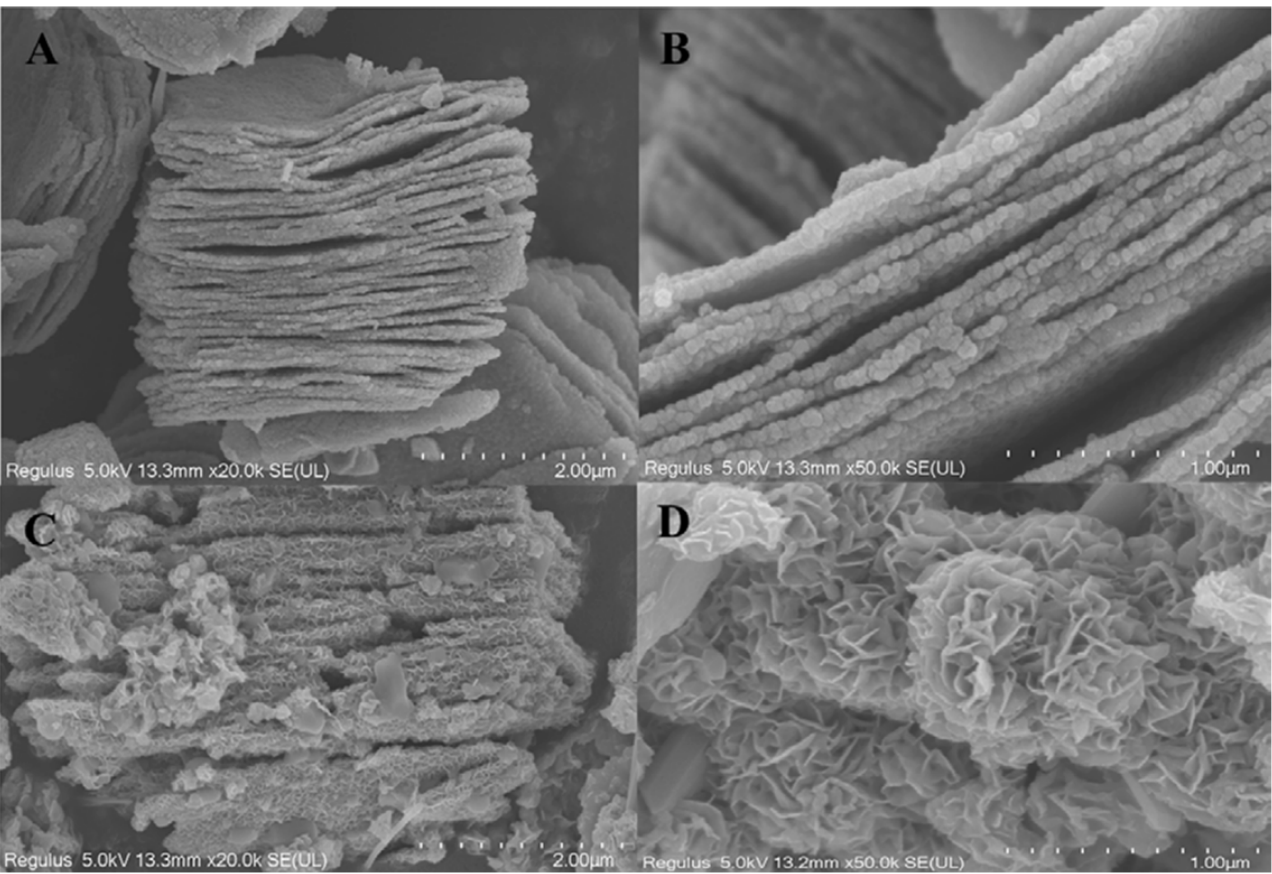
Figure 13. SEM images of pristine Ti3C2 ( A , B ) and Ti3C2-MoS 2 ( C , D ). Scale bar = 2 µm and 1 µm. The flower-like particles on layered sheets are observed from the SEM image of Ti3C2-MoS 2 from ref. [91]. Copyright 2022 Elsevier.